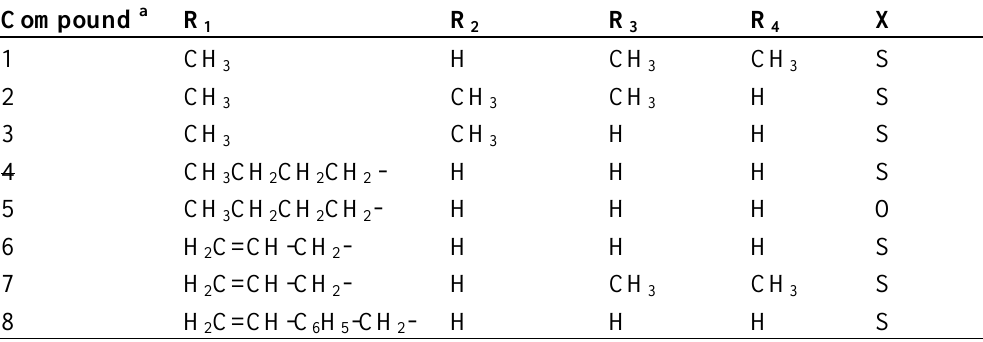
Table 1. The thiobarbituric acid derivatives used and their